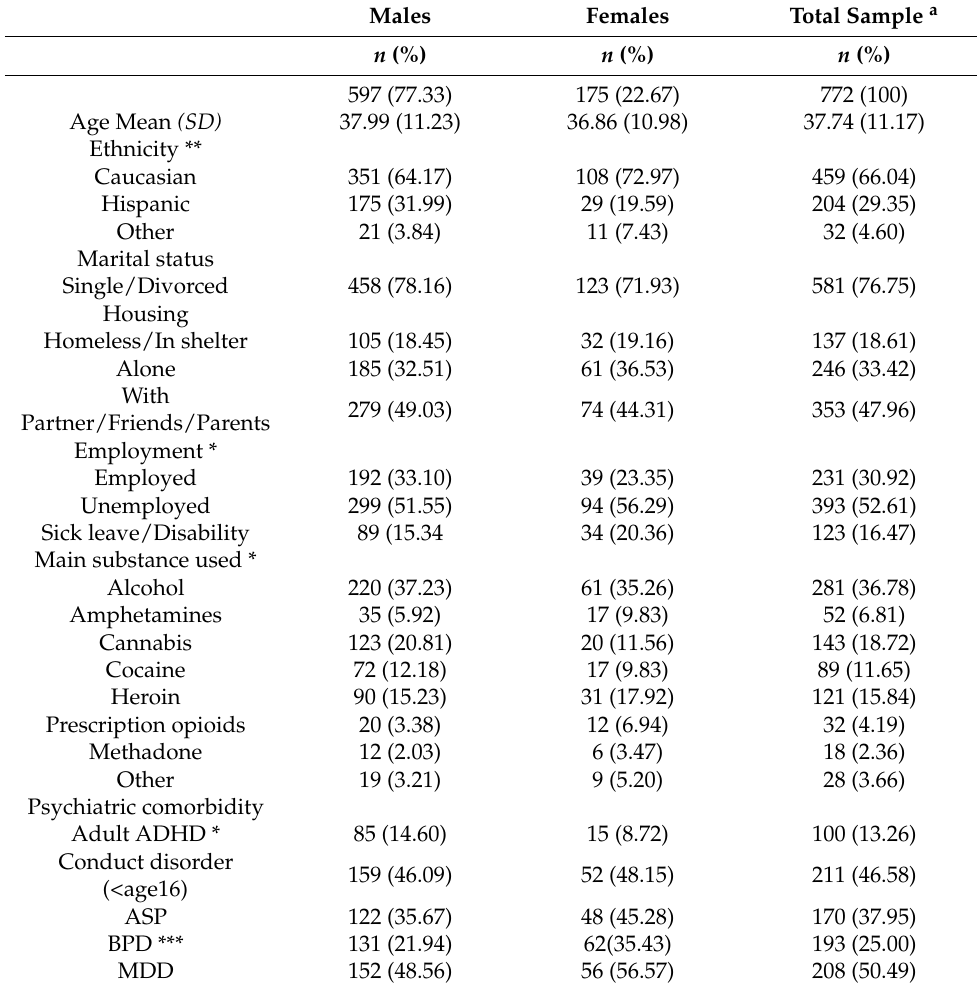
Table 2. Demographic and clinical characteristics of SUD treatment-seeking participants, by gender ( n =